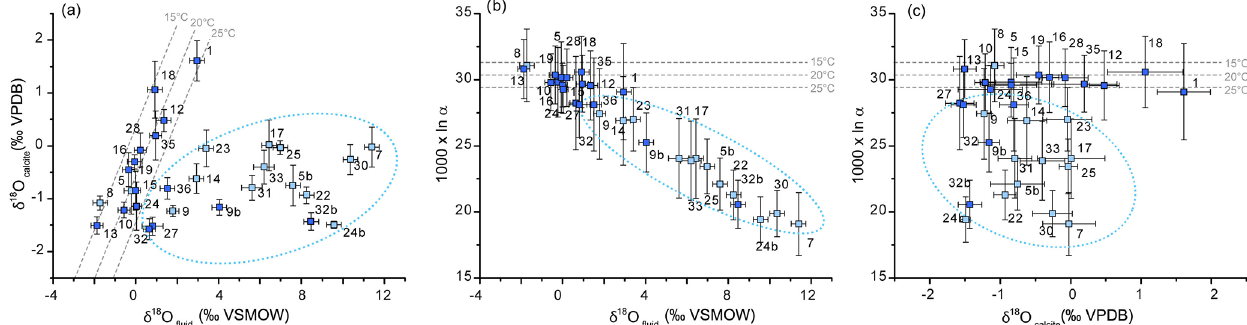
Figure 4. Analysis of the fractionation between speleothem calcite and fluid inclusions. Panel (a) shows the measured δ 18 O c values in speleothem carbonate (Warken et al., 2020) vs. measured δ 18 O f in speleothem fluid inclusion water (this study). (b) Fractionation δ c/f = 1000ln α between carbonate and fluid inclusion water vs. the δ 18 O f values. (c) Fractionation 18 ε c/f = 1000ln α vs. δ 18 O c values. Numbers indicate the sample IDs of the fluid inclusion measurements (Table S2). The uncertainty of the calculated fractionation is estimated from propagating the analytical error of the fluid inclusion measurements, and from the range of the δ 18 O c calcite value due to dating and sampling uncertainty. Blue symbols indicate samples with water content > 0.55µLg − 1 , and light blue symbols water content < 0.55µLg − 1 . The grey lines indicate the water–calcite oxygen isotope fractionation relationship after Tremaine et al. (2011) for cave temperatures of 15, 20 and 25 ◦ C respectively. The ellipses indicate the samples which are allocated to cluster (2) due to large fractionation effects in δ 18 O f . All of these samples also plot off the water–calcite oxygen isotope fractionation curve for 25 ◦